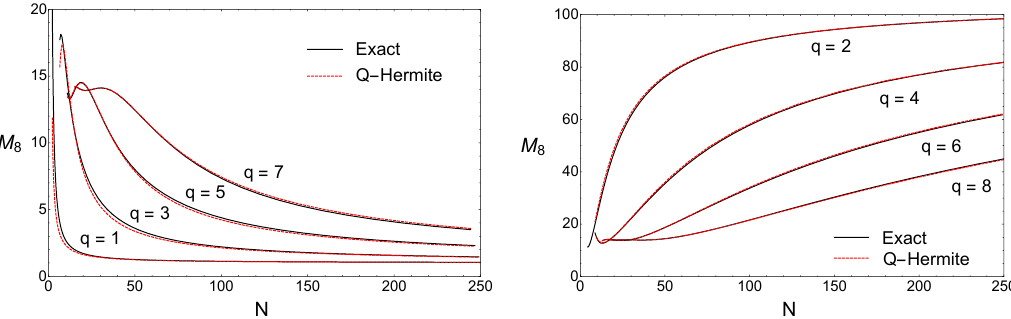
Figure 6 . The N -dependence of the eighth moment of the eigenvalue density of the SYK model for q = 1 ; 3 ; 5 ; 7 (left) and q = 2 ; 4 ; 5 ; 8 (right). We compare the exact result (solid curve) to the Q-Hermite result